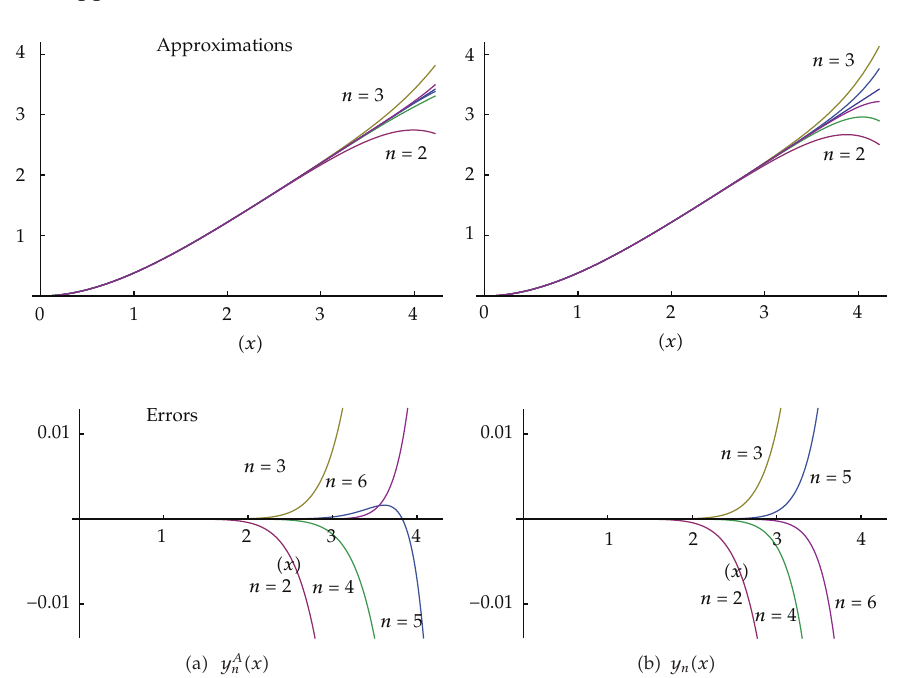
Figure 2: The Adomian solutions y A n (cid:3) x (cid:4) and their errors in (cid:3) a (cid:4) and presented solutions y n (cid:3) x (cid:4) and their errors in (cid:3) b (cid:4) for the Falkner-Skan equation with β (cid:6) 0 . 5.